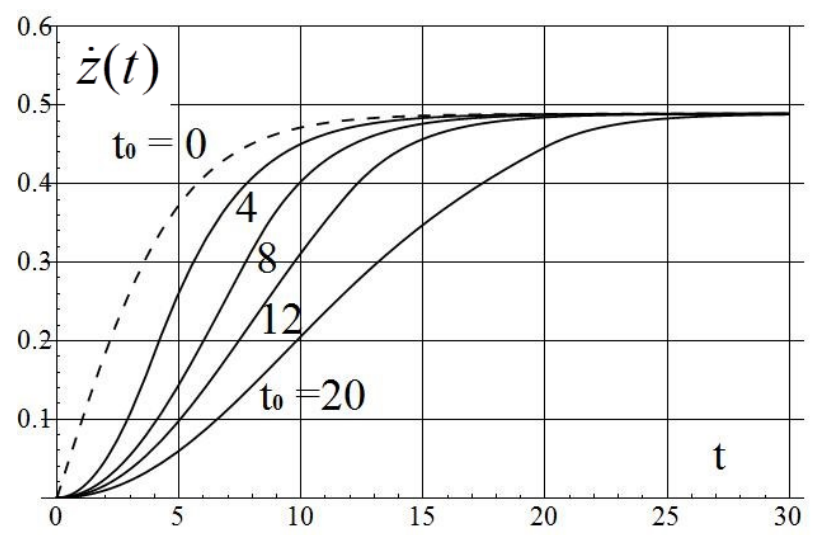
Figure 6. Speed of submersion of the cylinder versus time in accelerated motion and various magnitudes of t 0 , η = 0.01, l c = 1